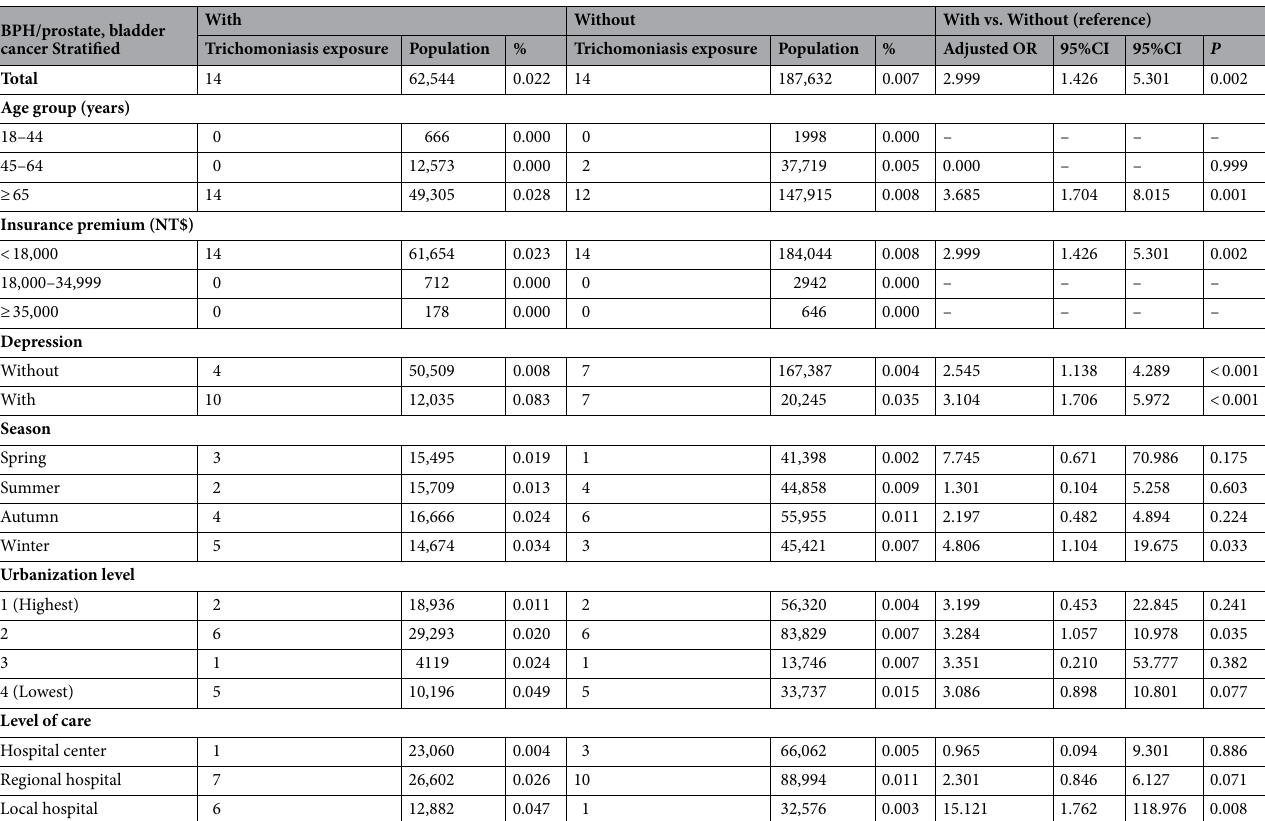
Table 3. Risk of BPH/prostate cancer and bladder cancer stratified by variables listed in the table by using multivariable logistic regression. Adjusted OR adjusted odds ratio: adjusted for the variables listed in Table 2, CI confidence interval.